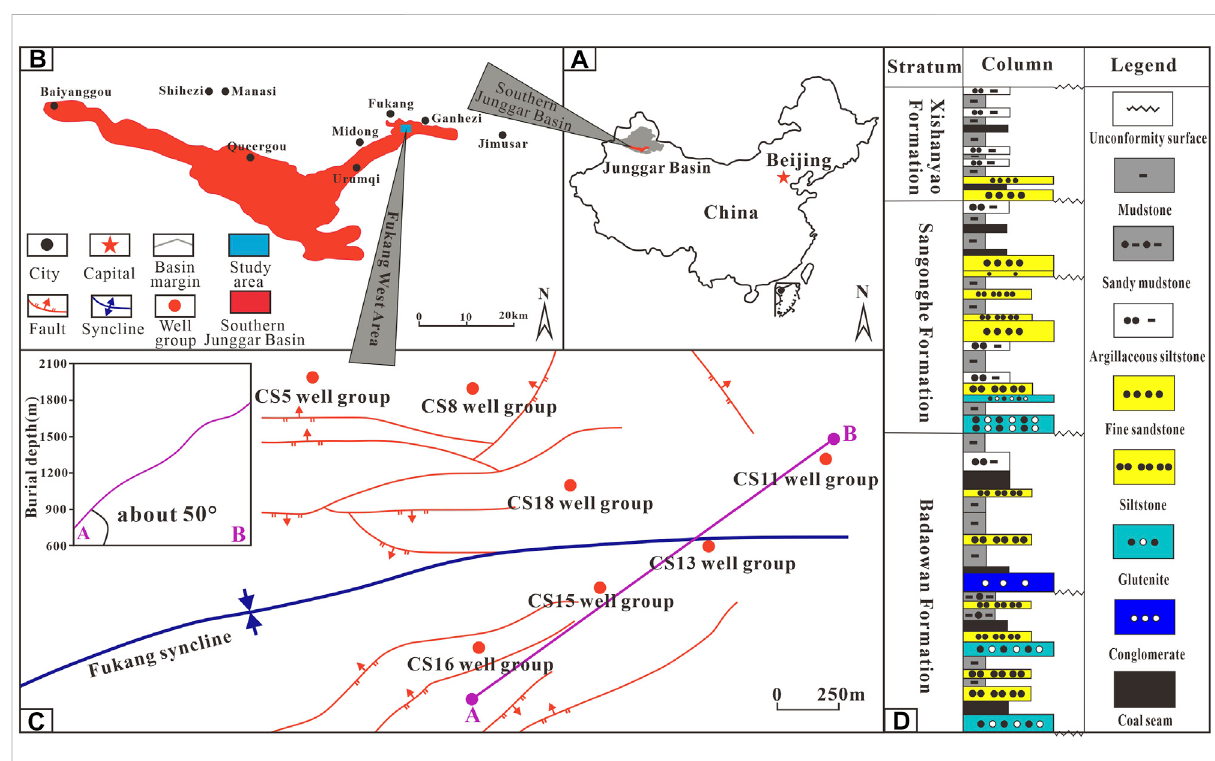
FIGURE 1 (A) Location mapofthesouthernJunggar Basin. (B) GeologicalstructureofthesouthernJunggar Basin. (C) Structural outline and welllocation distribution in the Fukang west area. (D) Coal-bearing